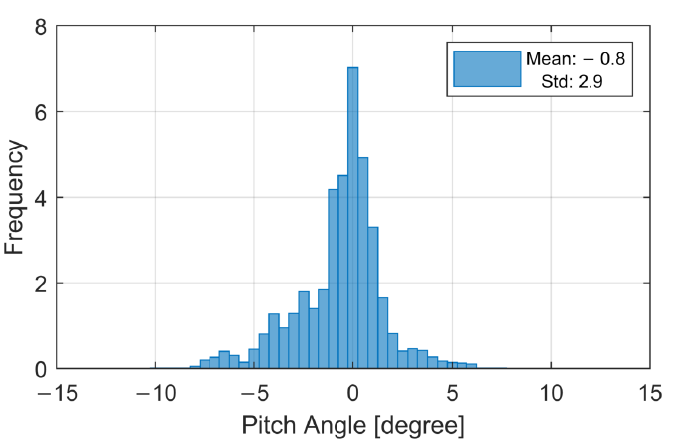
Figure 5. Pitch angle deviation during the HRTF measurement from all